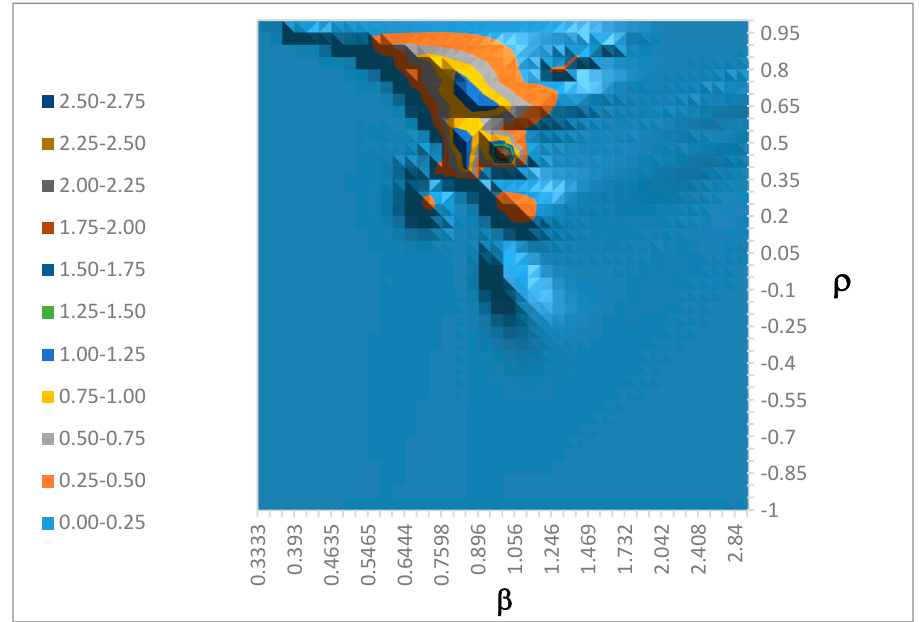
Figure 3. Marginal of g* on ( ρ , β ).